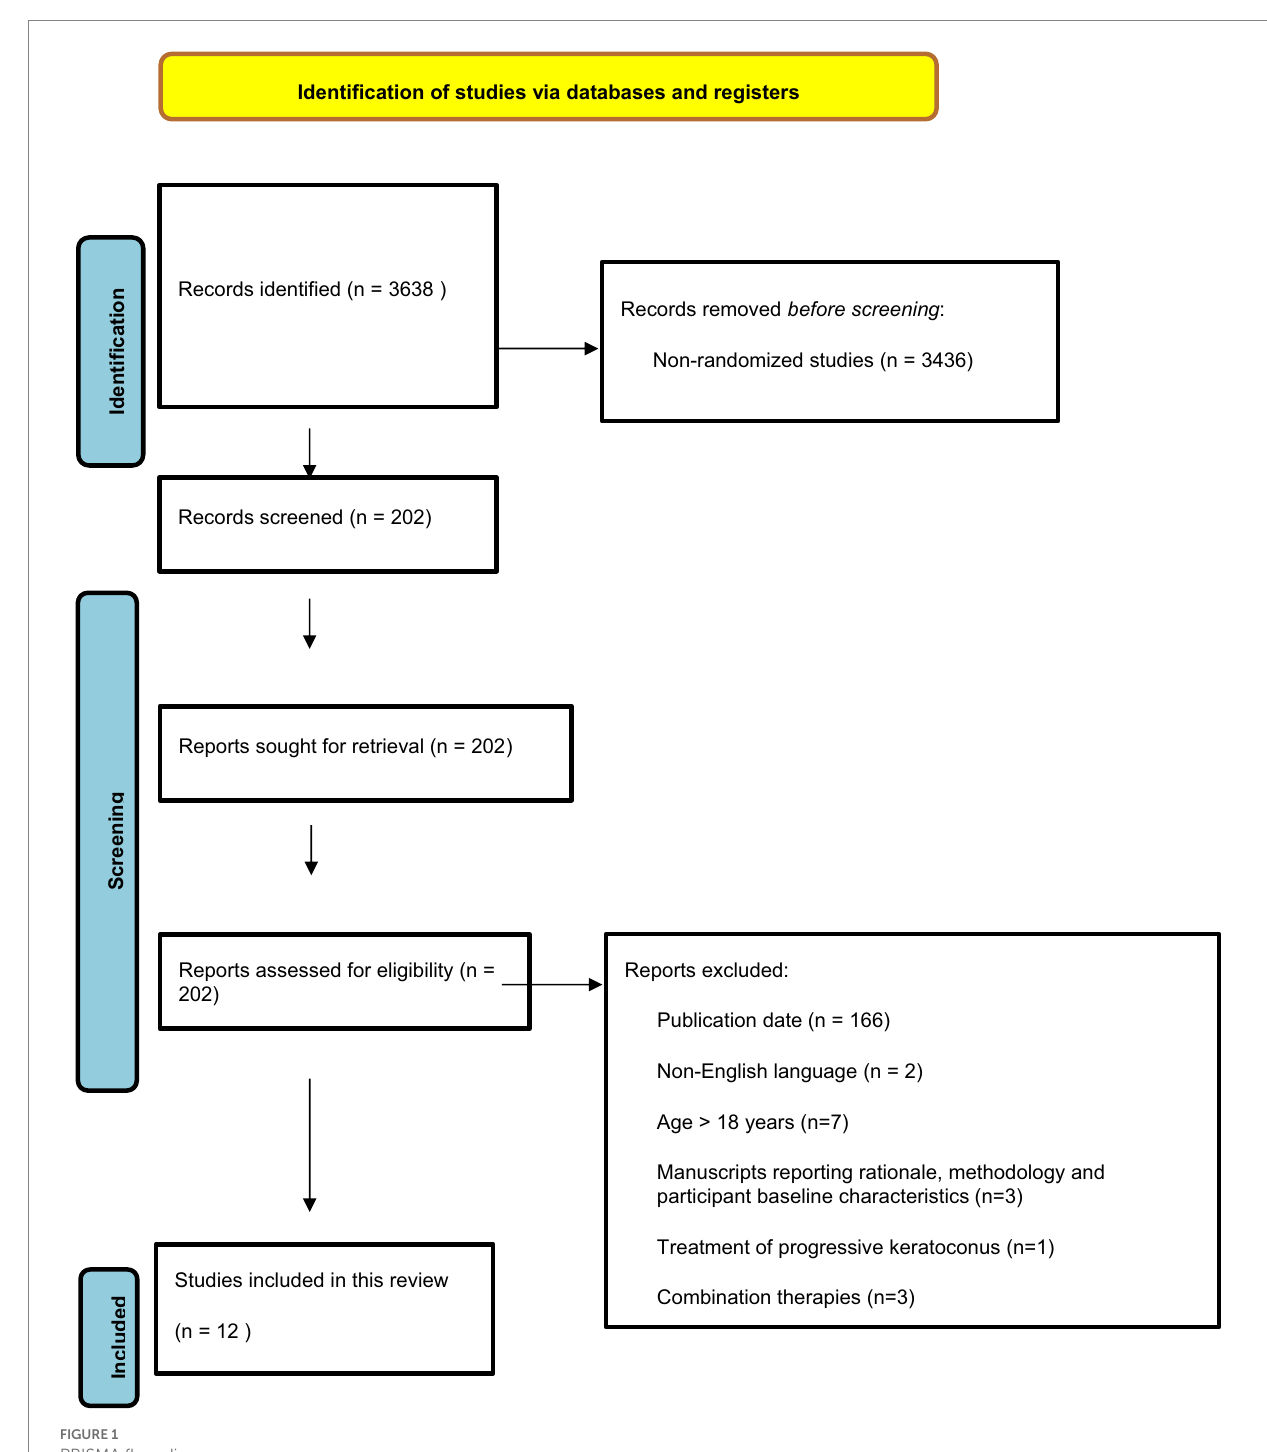
FIGURE 1 PRISMA flow